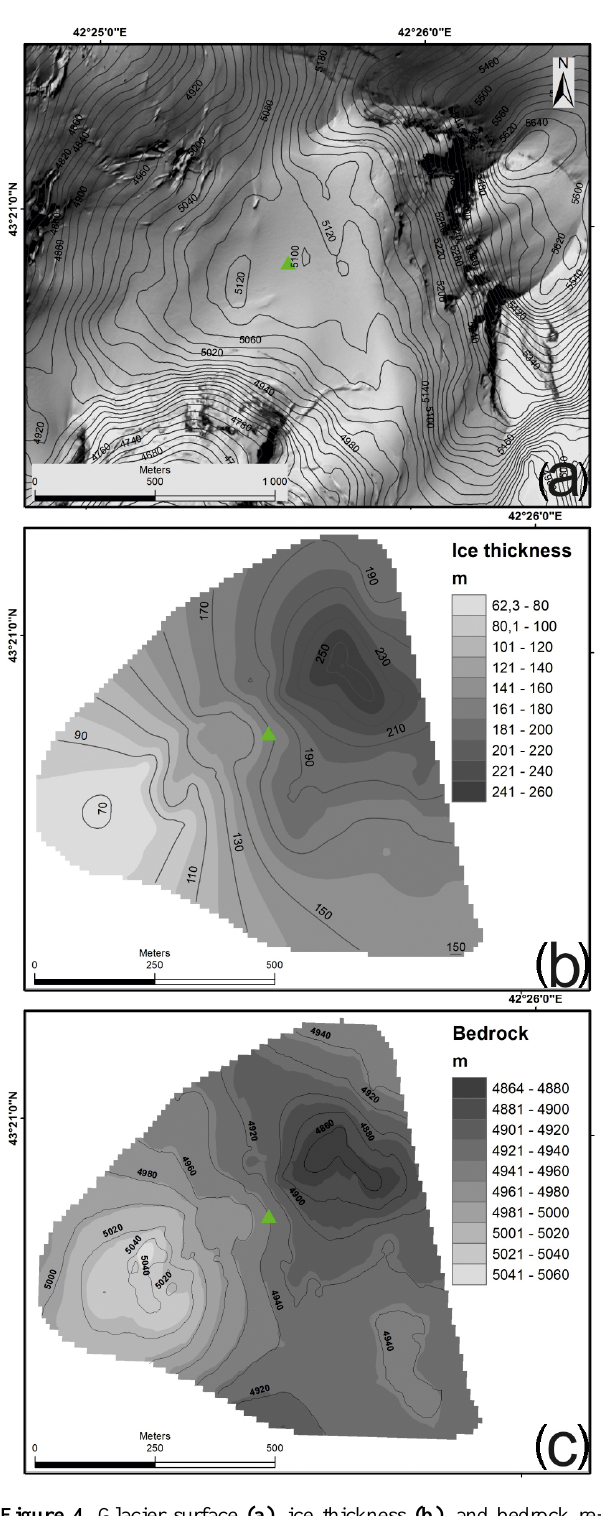
Figure 4. Glacier surface (a) , ice thickness (b) , and bedrock re- lief (c) on the western Elbrus plateau. The green triangle marks the position of the drilling